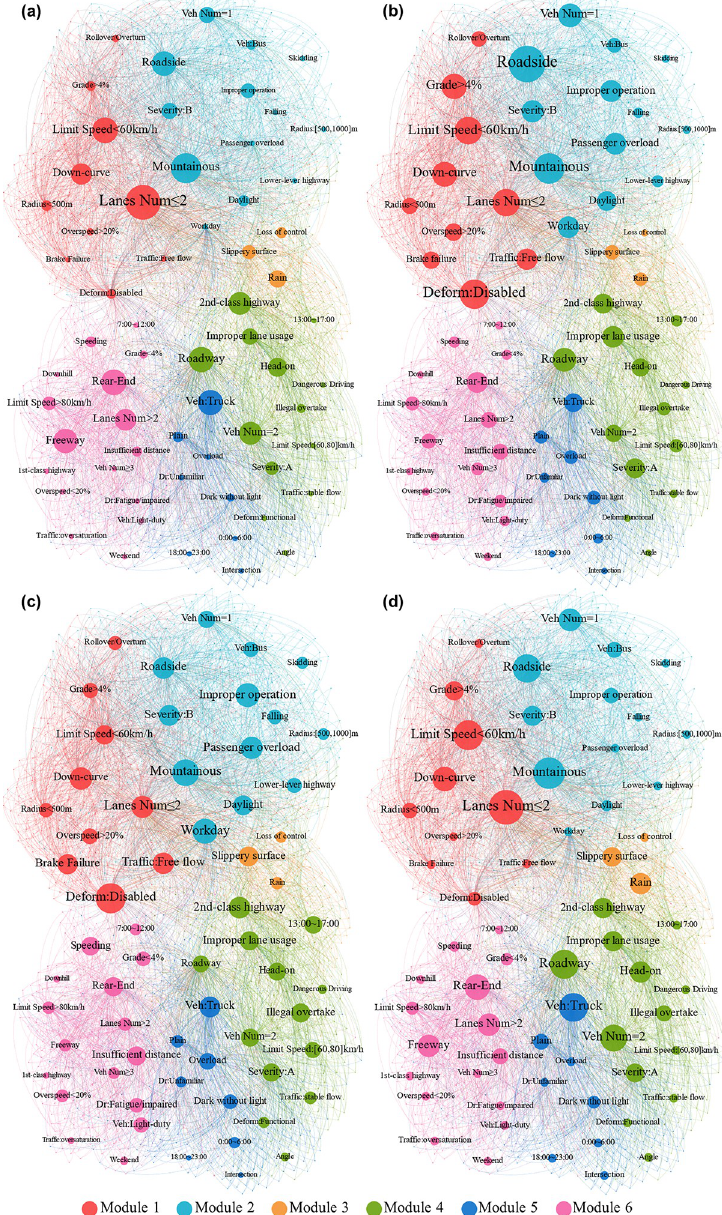
Fig 2. Modular RGS based on different graph properties. (a) In-degree, (b) Out-degree, (c) Betweenness, and (d)